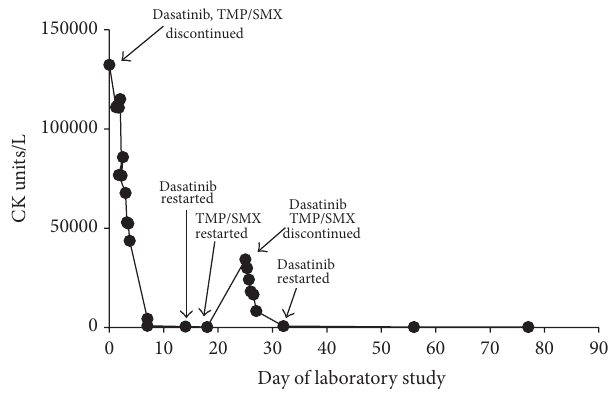
Figure1:Plotofcreatinekinaselevelsversusdayoflaboratorystudy. Relationship of creatine kinase levels to medication administration or cessation is indicated by